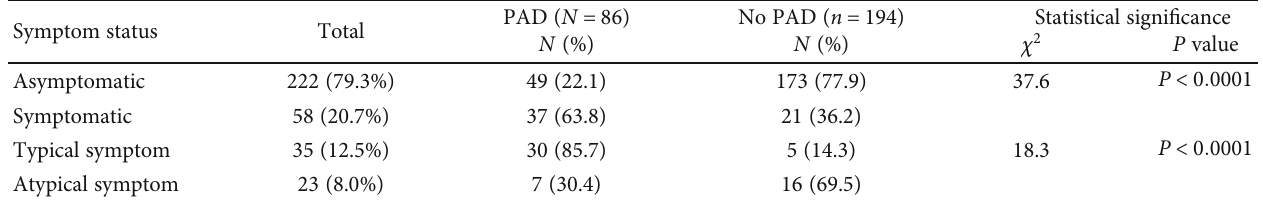
Table 2: Comparison of PAD symptoms between PAD-positive and PAD-negative DM patients, Debre Tabor, Northwest Ethiopia, 2019. Symptom